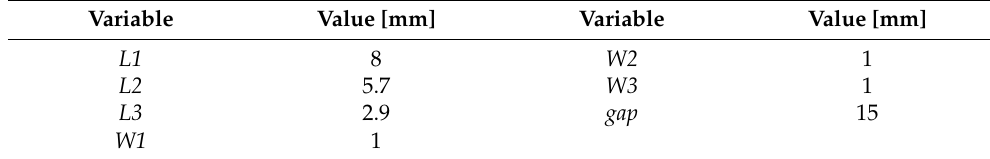
Table 6. The values of the physical dimensions of the eighth-order filter.